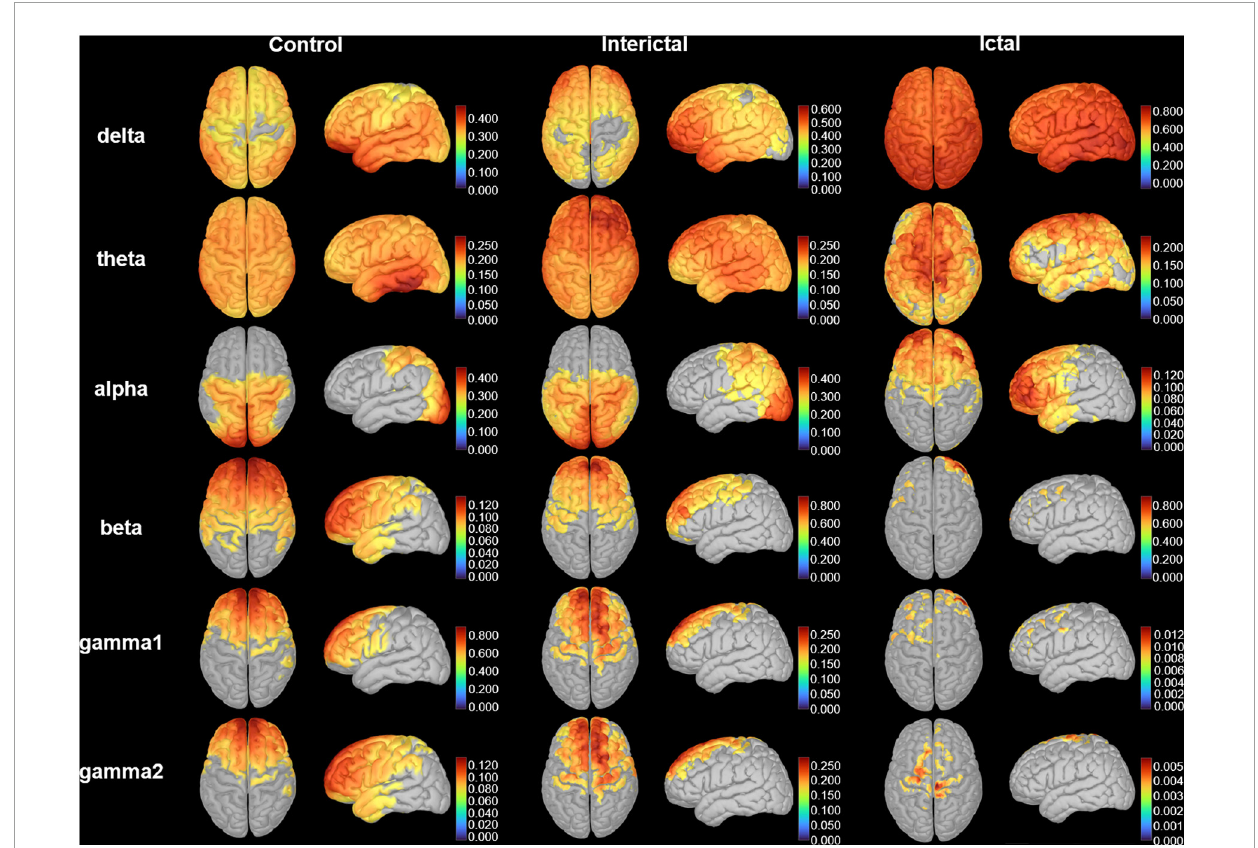
FIGURE2 Cortical activation. The distribution of the average cortical activation in control, interictal and ictal data. The activation maps are shown from the top and lateral views. Values range between 0 and 1, indicating the power of cortical signals relatively to the total signal power across the frequency spectrum. Only the cortical sources with a strength larger than 60% of the maximal value are displayed. The current strength for cortical sources is color-coded with large values represented in red.